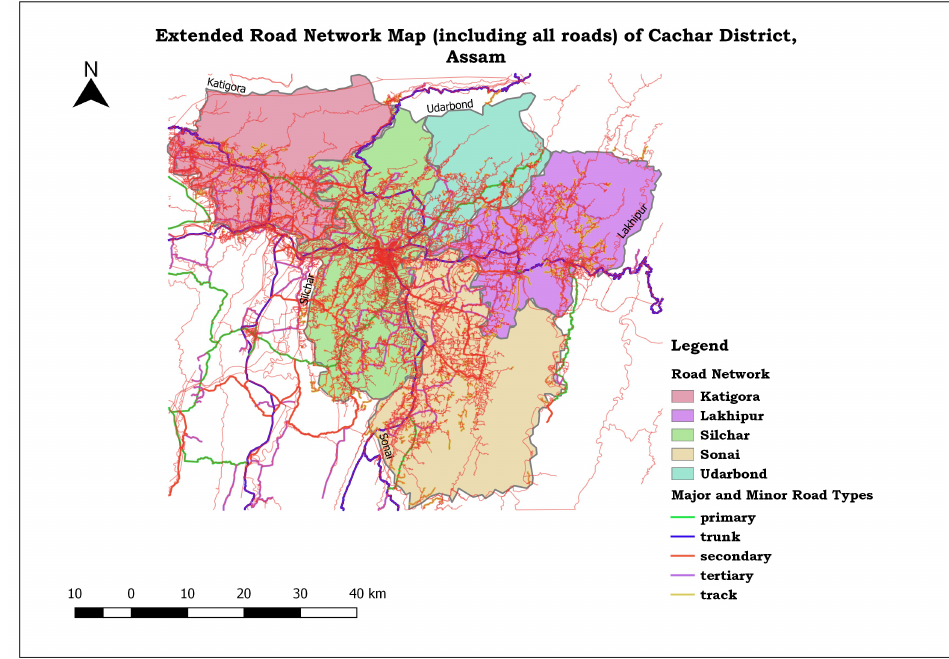
Figure 2. Extended road network map of Cachar